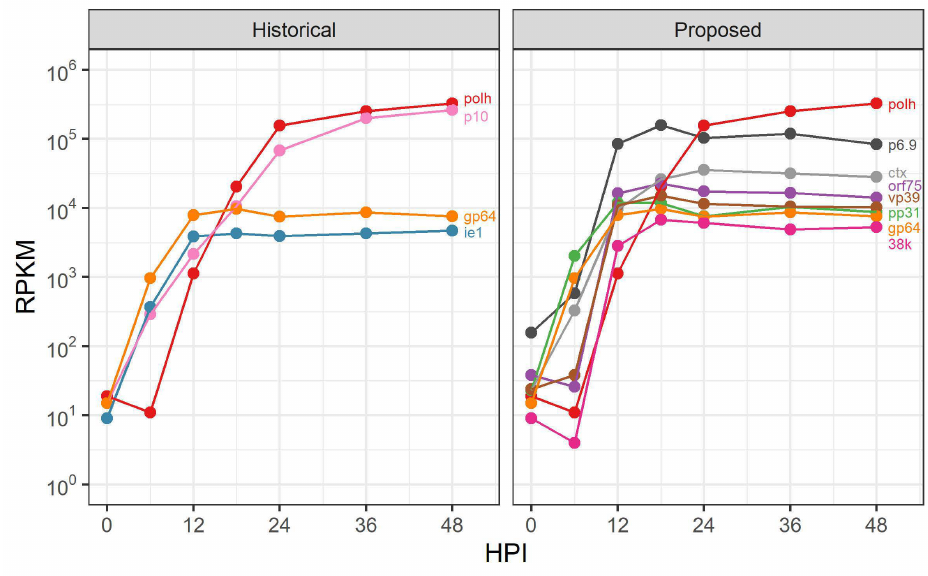
Figure 1. The promoters included on commercially available transfer plasmids have drastically different transcription profiles. ( Left panel ). The transcript abundance of Ac MNPV polh, p10, gp64, and ie1 ORFs, which are among the only promoters available on commercial transfer plasmids for foreign gene expression. ( Right panel ). The transcript abundance profiles of Ac MNPV ORFs selected for evaluation of the upstream promoter regions in this study. Promoters were selected for expression profiles between polh/p10 and